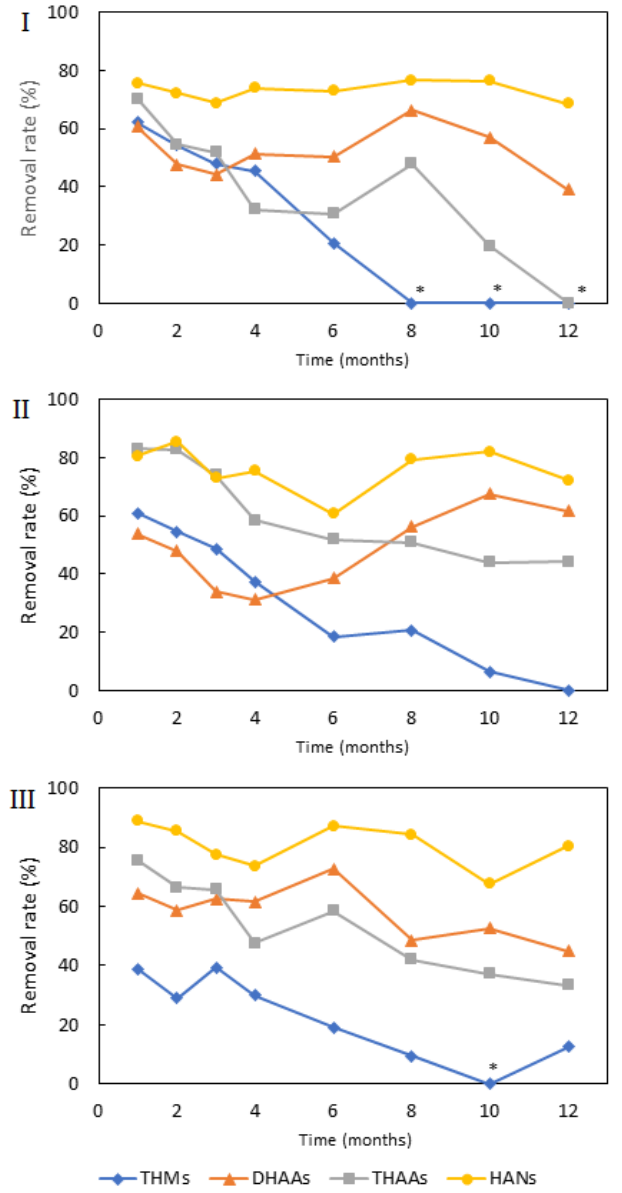
Figure 3. Removal rate of the GAC adsorbents at waterworks I – III (* Calculated removal rate was below